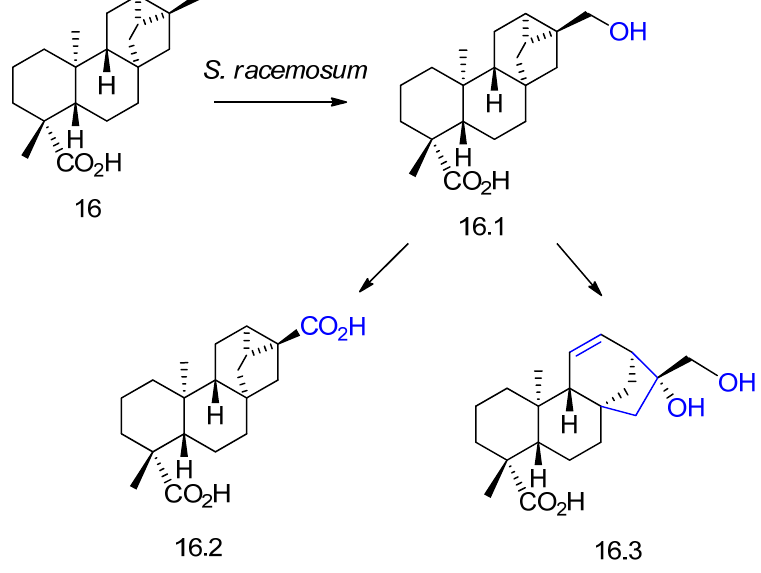
Figure 17. Chemical structures of the derivatives 16.1 , 16.2 , and 16.3 obtained by biotransformation of trachyloban ‐ 19 ‐ oic acid ( 16) with Syncephalastrum racemosum [65] .